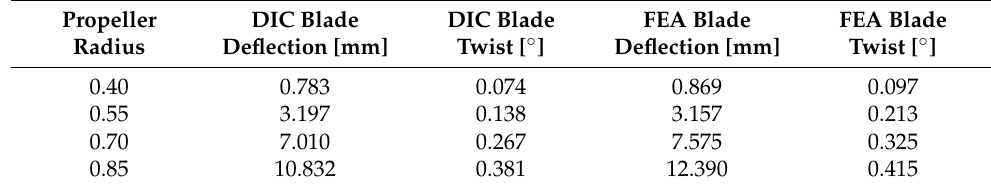
Table 4. Calculation of blade deflection and twist from the plots in Figure 14.